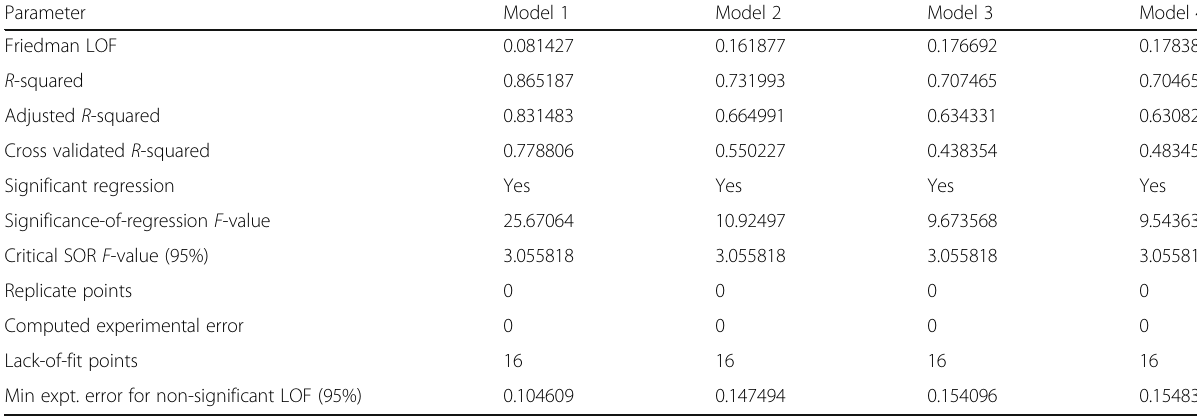
Table 5 Statistical parameters of built